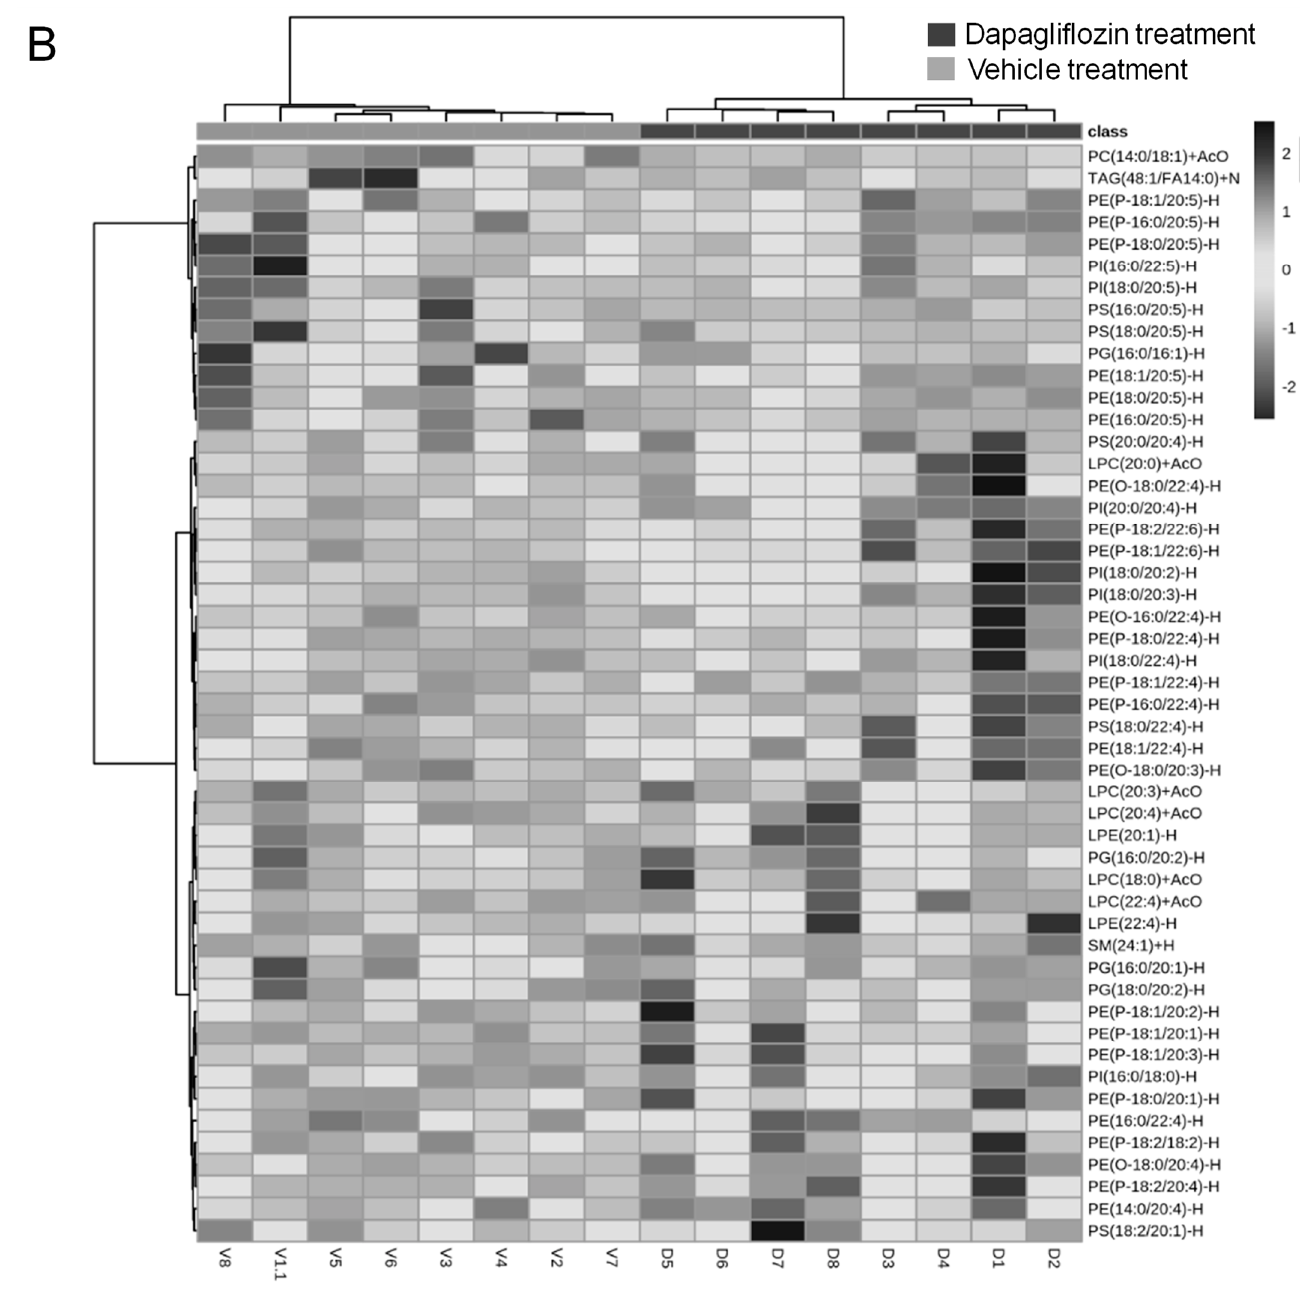
Figure 1. Analysis of lipids in the kidneys of dapagliflozin- or vehicle-treated salt-loaded hypertensive diabetic db/db mice. ( A ) Volcano plot showing 34 lipids that are significantly down-regulated and 19 lipids that are significantly upregulated in the kidneys of diabetic db/db mice treated with dapagliflozin compared to vehicle. A 2.0-fold change threshold and a p -value threshold of 0.05 were applied. Data were normalized by the mean and then to the median in MetaboAnalyst with Pareto scaling. The points representing specific lipids on the left (value < 0) are expressed at a lower level, and those on the right (value > 0) are expressed at a higher level, in the dapagliflozin group com- pared to the vehicle group. ( B ) Heatmap with Euclidean distance measure, Ward clustering method showing the top 50 lipids, with each colored cell on the map corresponding to a concentration value in the data table.